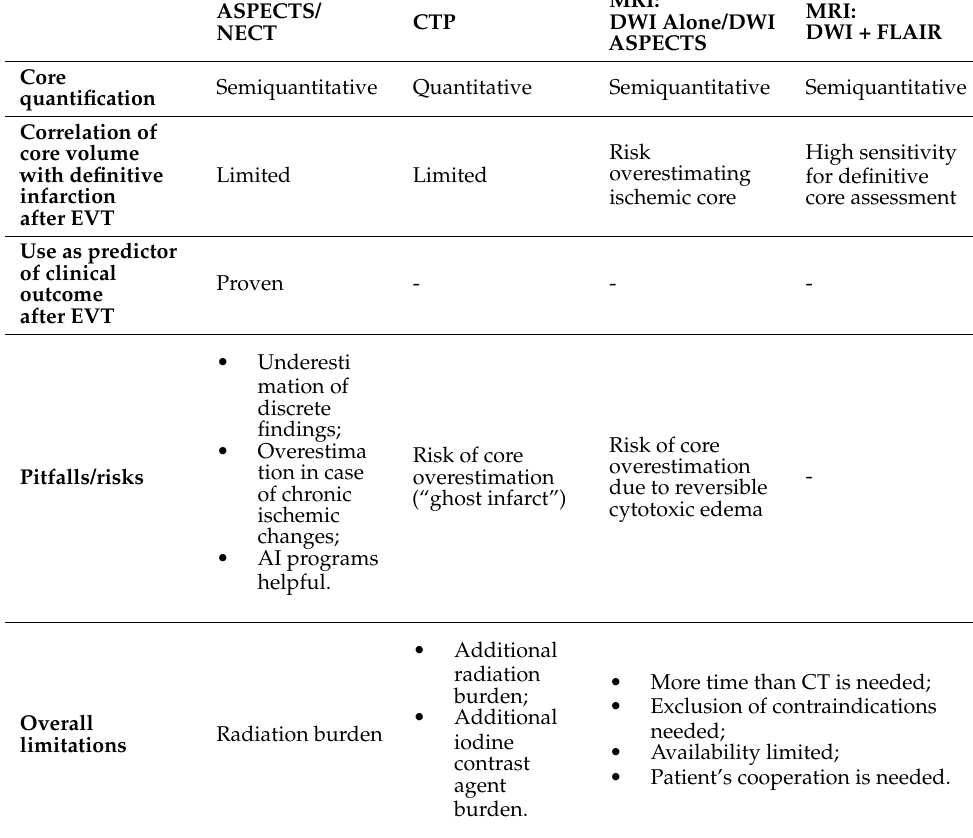
Table 2. CT and MRI in the ischemic core evaluation in the early time window.